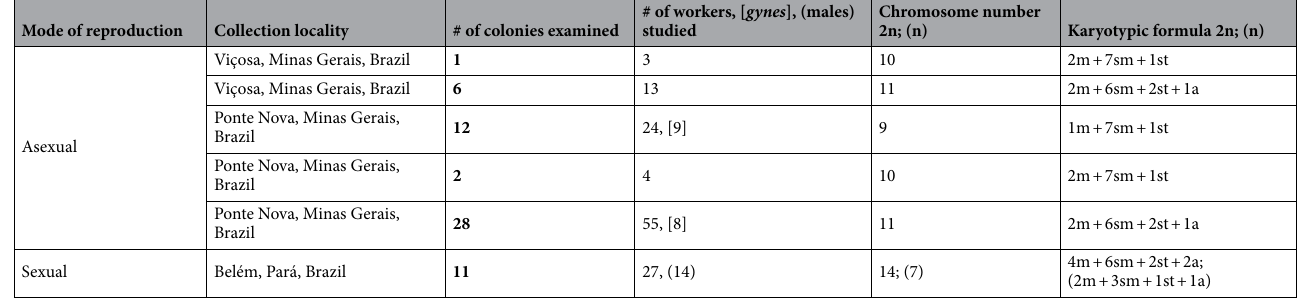
Table 1. Colonies of Mycocepurus smithii studied for the cytogenetic comparison. Information about the mode of reproduction, collection locality of the sample, number of colonies examined, number of workers, gynes and males analyzed via classical and molecular cytogenetic methods, diploid (2n) and haploid (n) chromosome numbers, and karyotypic formula are